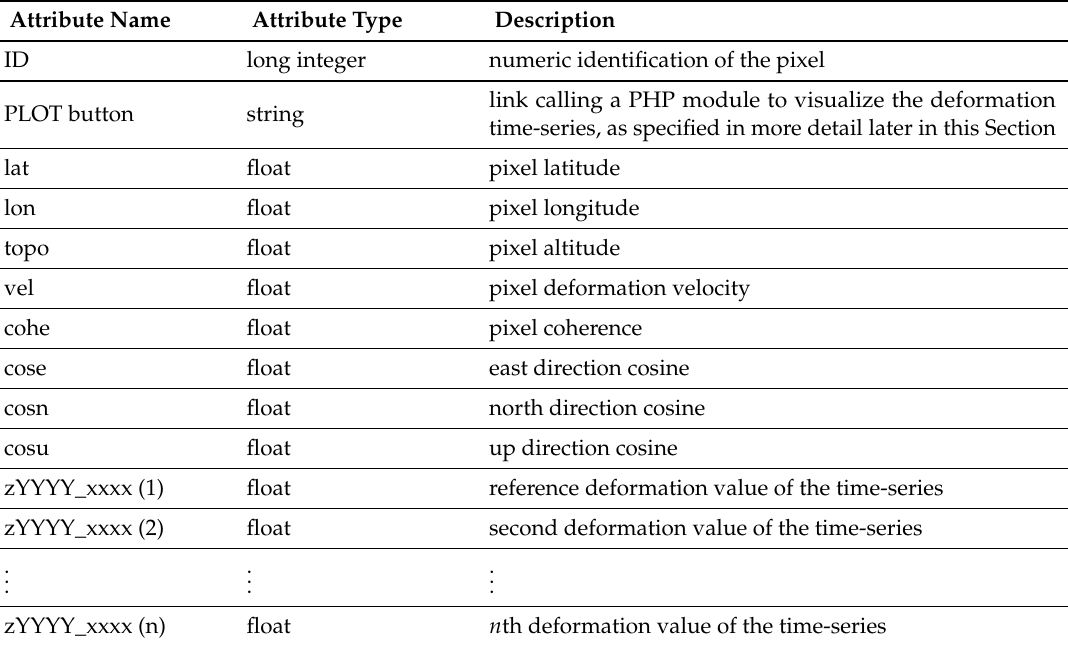
Table 1. Relation schema of the geodatabase